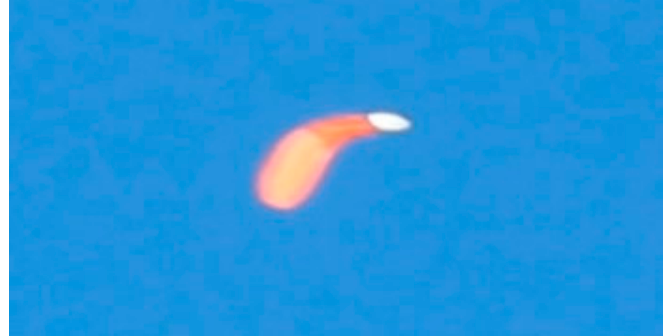
Figure 20. TA2 wing deflection under aerodynamic loads.